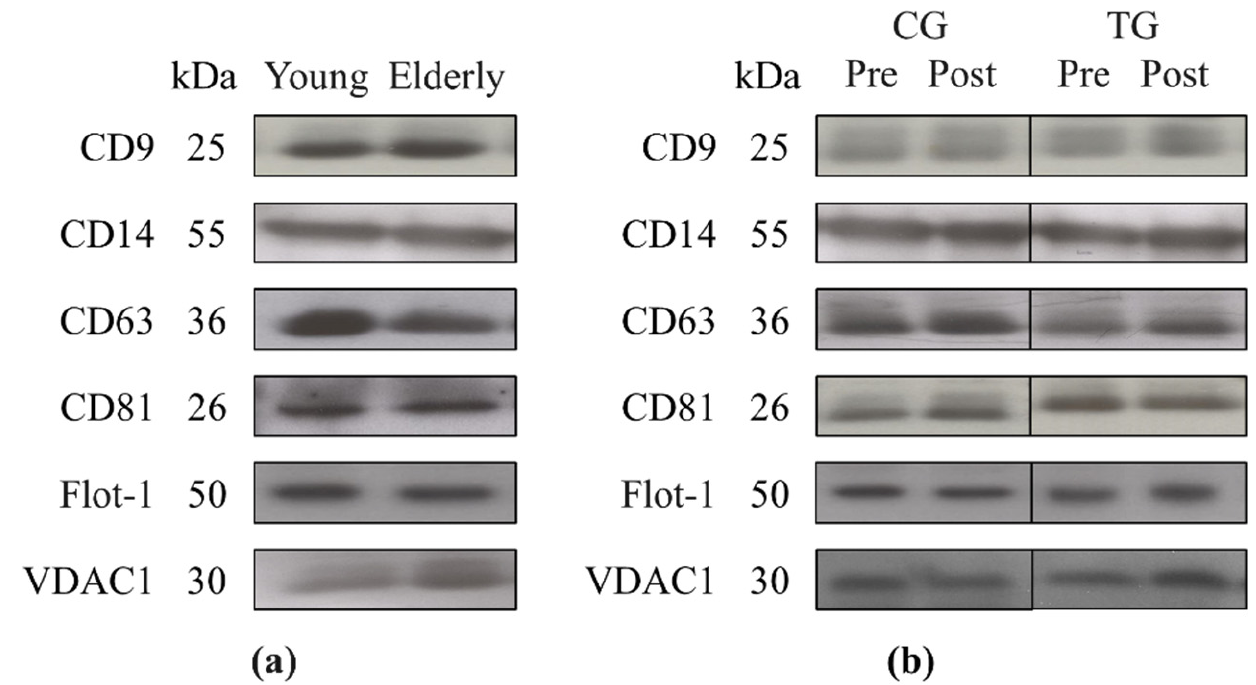
Figure 1. Representative Western blots showing the effects of aging (12 young vs. 38 elderly subjects) ( a ) and resistance training (CG ( N = 10) vs. TG ( N = 28)) ( b ) on Flot-1, CD63, CD81, CD9, CD14, and VDAC1 protein expression in plasma